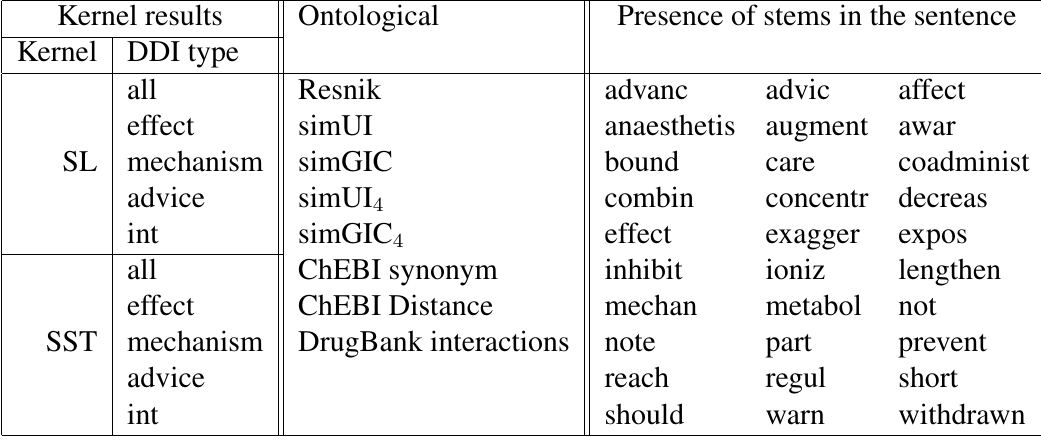
Table 3: Feature set for the ensemble classifier, divided in three groups.